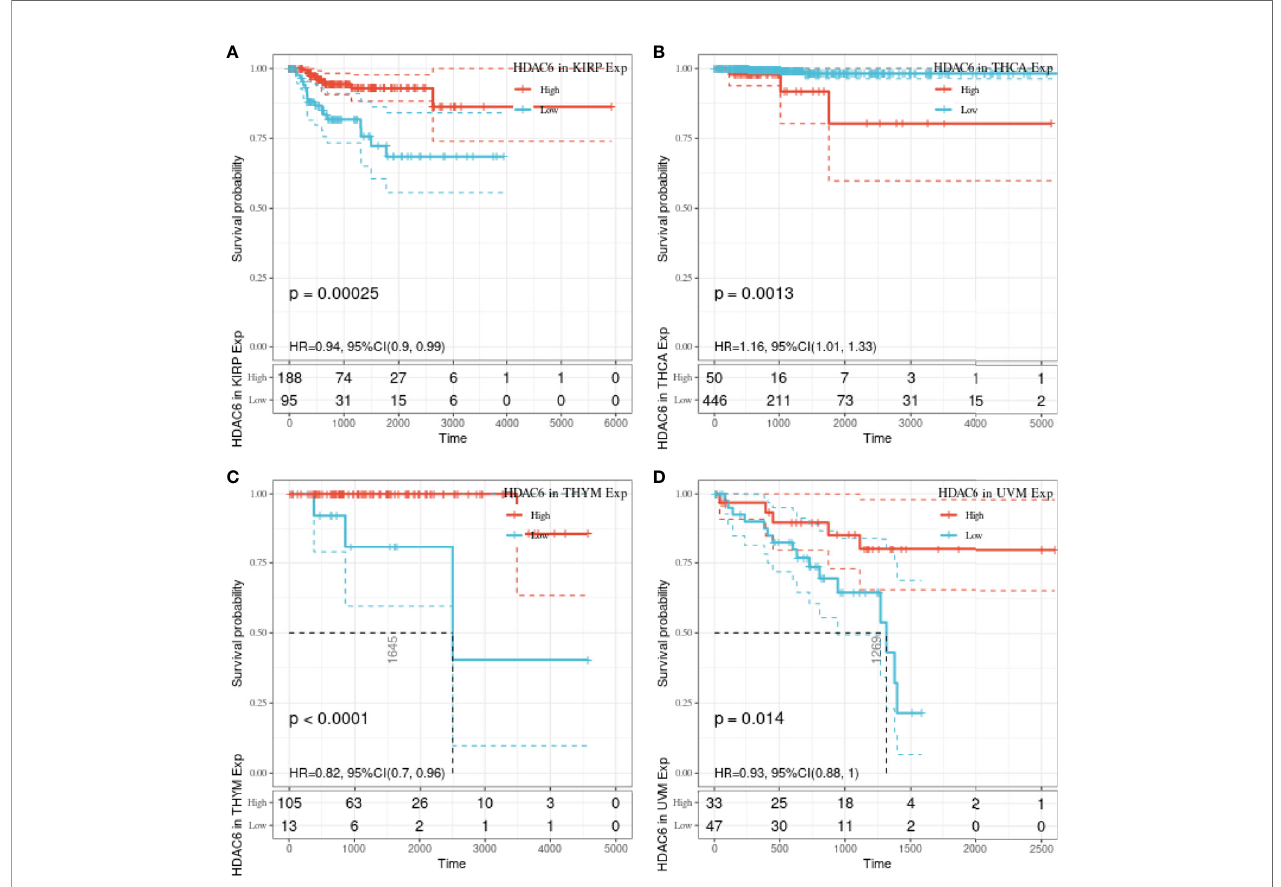
FIGURE 5 | Relationship between HDAC6 and KIRP, THCA, THYM, UVM DSS. (A) The relationship between HDAC6 high and low expression levels and KIRP DSS was analyzed by K – M survival. (B) The relationship between HDAC6 high and low expression levels and THCA DSS was analyzed using K – M survival. (C) Relationship between HDAC6 high and low expression levels and THYM DSS using K – M survival analysis. (D) Relationship between HDAC6 high and low expression levels and UVM DSS using K – M survival